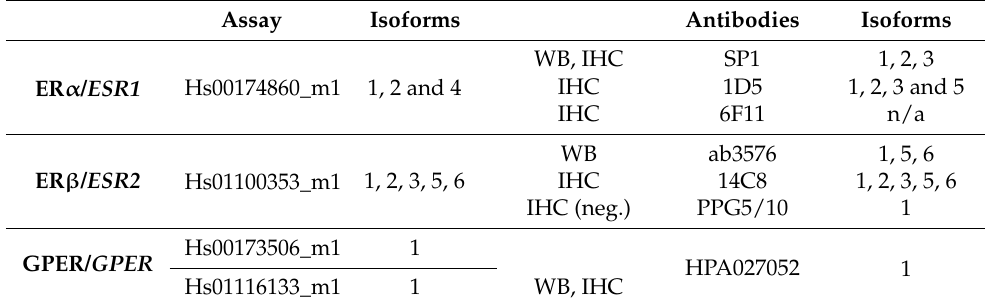
Table 4. Detection of different transcripts and isoforms of ESR1, ESR2, and GPER by qPCR assays and different antibodies. Assay